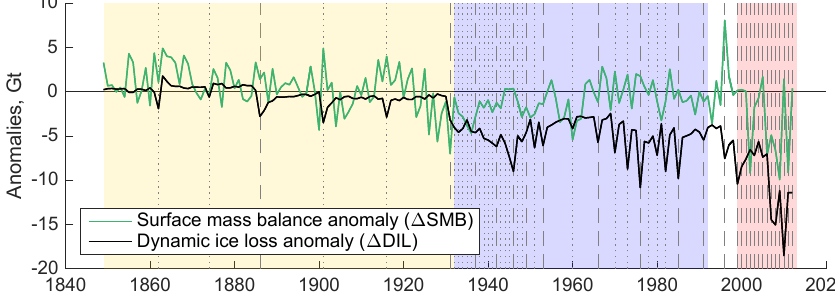
Figure 3. Simulated ice mass changes from anomalies (relative to 1964–1990 mean values) for the simulation ISSM PT . The background is highlighted in yellow for periods of time where (cid:49) SMB controlled MB, blue is where ice mass loss is driven by (cid:49) DIL and red, where (cid:49) SMB and (cid:49) DIL have an equally increased influence on the MB. Prescribed termini changes are marked with dashed (observations) and dotted (interpolations) lines. Table 3. Observed vs. simulated ice mass changes (with ISSM PT ). Khan et al. (2013) a Larsen et al.